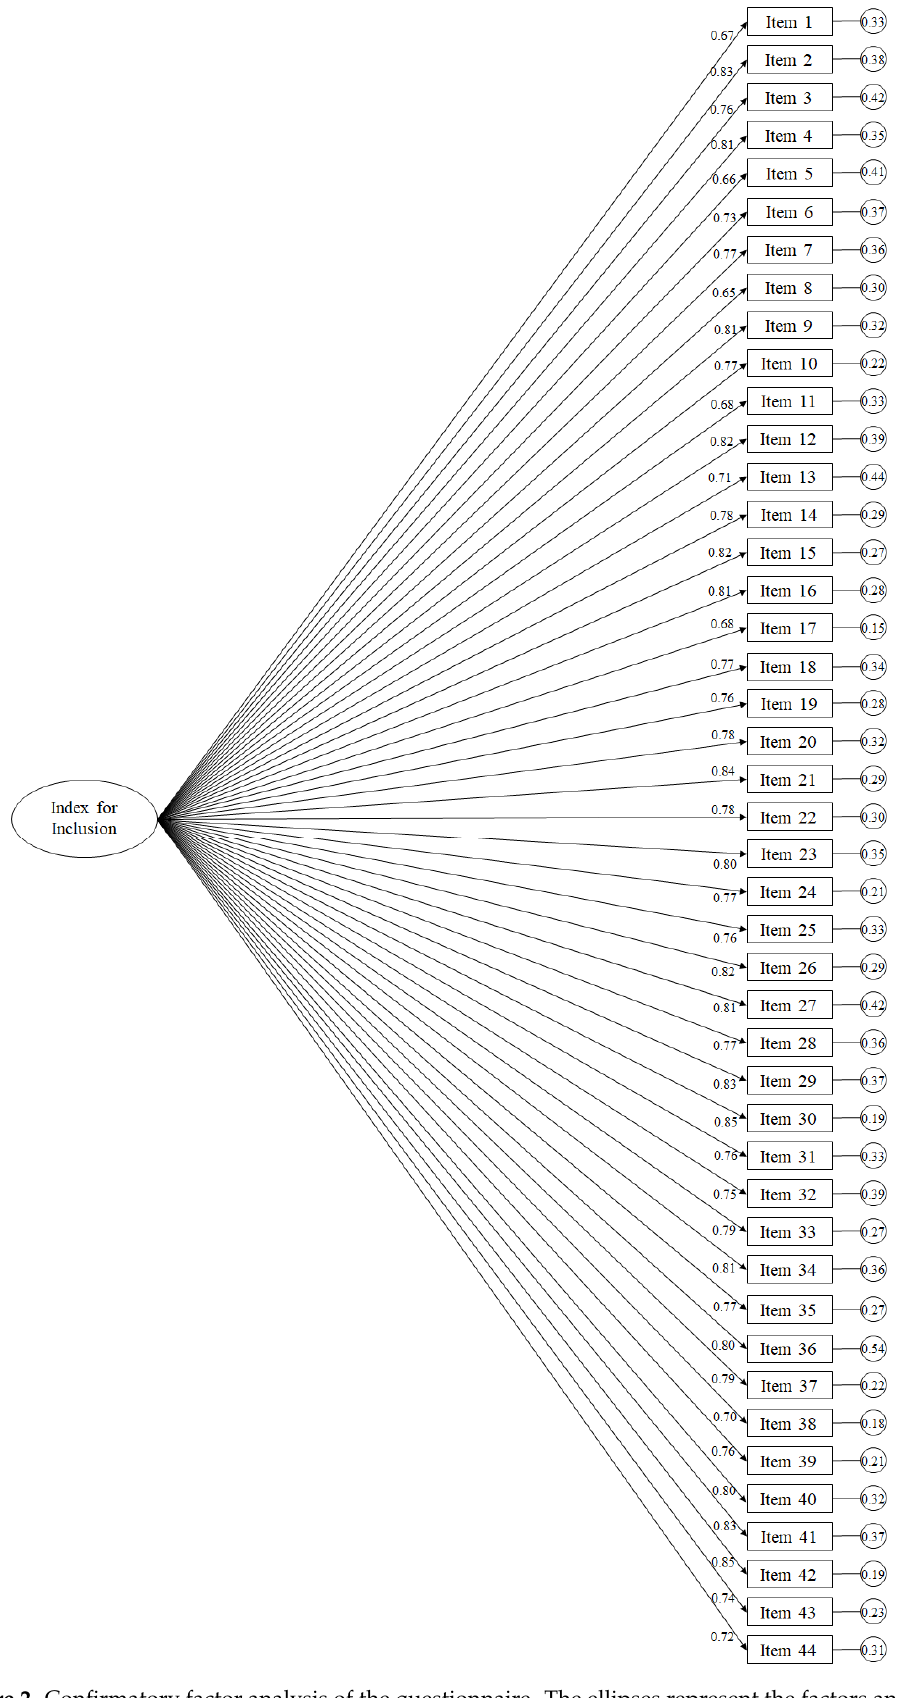
Figure 2. Confirmatory factor analysis of the questionnaire. The ellipses represent the factors and the rectangles represent the di ff erent items. The residual variances are shown in the small circles.